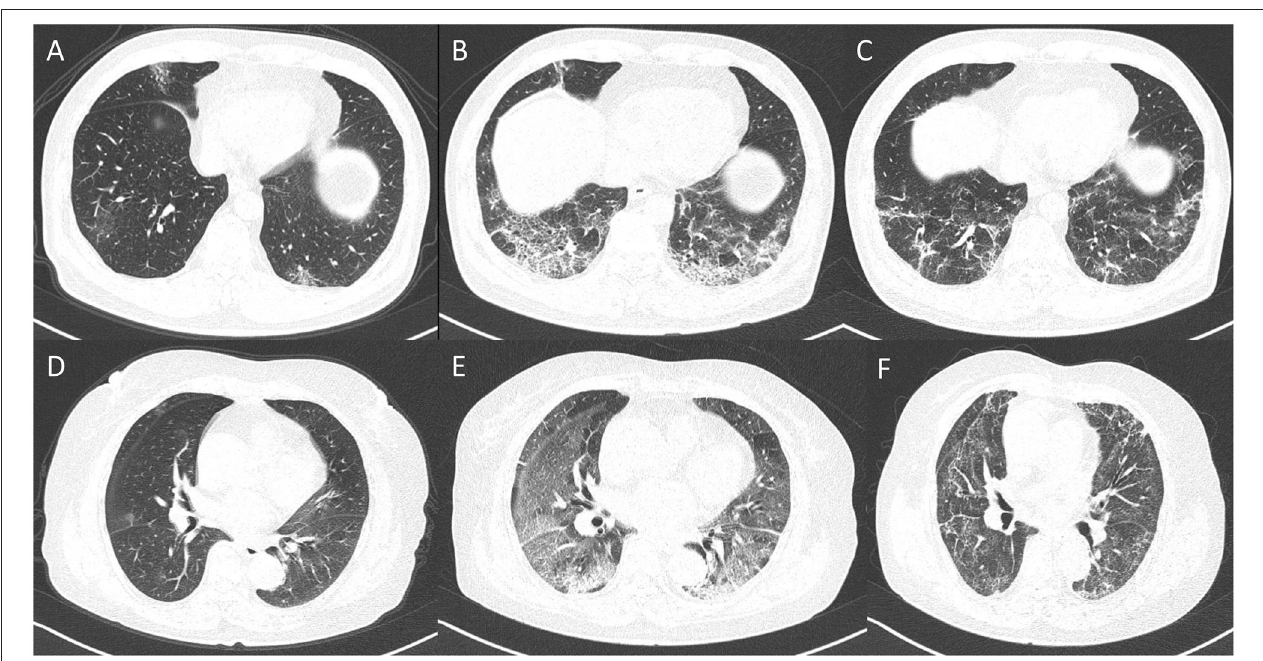
FIGURE 4 | Dynamic changes in lung lesions in two representative cases with COVID-19 pneumonia. A 65-year-old man: (A) scan obtained on day 2; multiple patchy GGOs were shown in the middle lobe and both lower lobes; the PPV, PGV, and PCV were 1.14, 1.07, and 0.07%, respectively. (B) Scan obtained on day 7 showed extensive GGOs with consolidation and crazy-paving pattern in the both lower lobes; the PPV, PGV, and PCV increased to 14.24, 11.38, and 2.86%, respectively. (C) Scan obtained on day 21 showed obvious absorption of abnormalities with fibrotic-like appearances; the PPV, PGV, and PCV were 7.73, 7.12, and 0.61%, respectively. A 67-year-old woman: (D) Scan obtained on day 2, small nodule of GGO was shown in the right lung; the PPV, PGV, and PCV were 0.19, 0.16, and 0.03%, respectively. (E) Scan obtained on day 10 showed extensive GGOs in both lungs with consolidation in the lower lobes; the PPV, PGV, and PCV increased to 48.67, 38.23, and 10.44, respectively. (F) Scan obtained on day 56 showed obvious absorption of GGOs and consolidation with fibrotic-like appearances; the PPV, PGV, and PCV were 39.47, 33.77, and 5.70%,